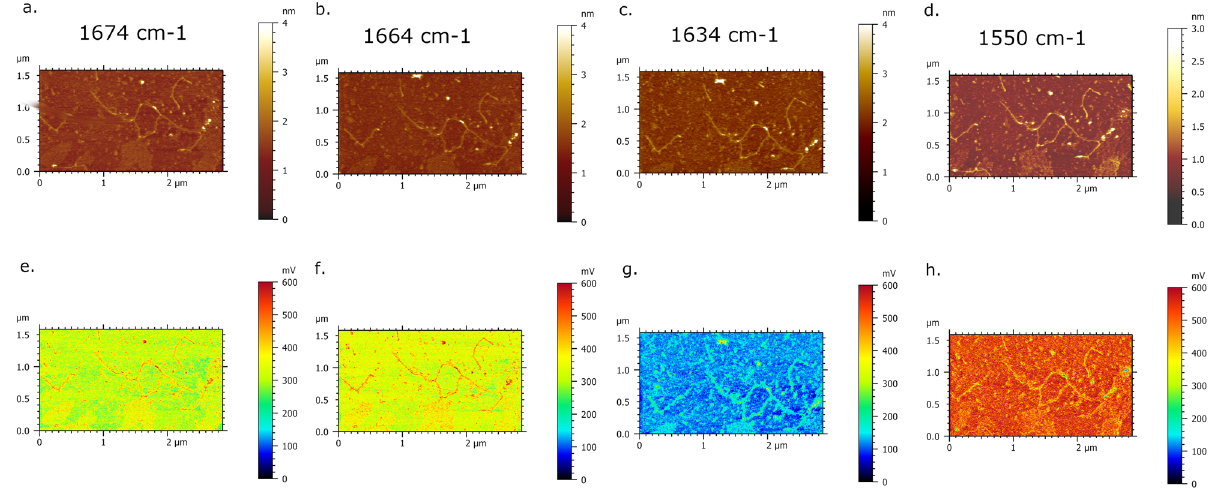
Figure 5. AFM-IR imaging of DNA single molecule deposited onto nickel functionalized mica surface. ( a – d ) AFM morphology map and corresponding ( e – h ) IR absorption maps of DNA single molecule with a highest contrast-absorption of DNA acquired at 1674 cm −1 , 1664 cm −1 , 1634 cm −1 and 1550 cm −1 ,